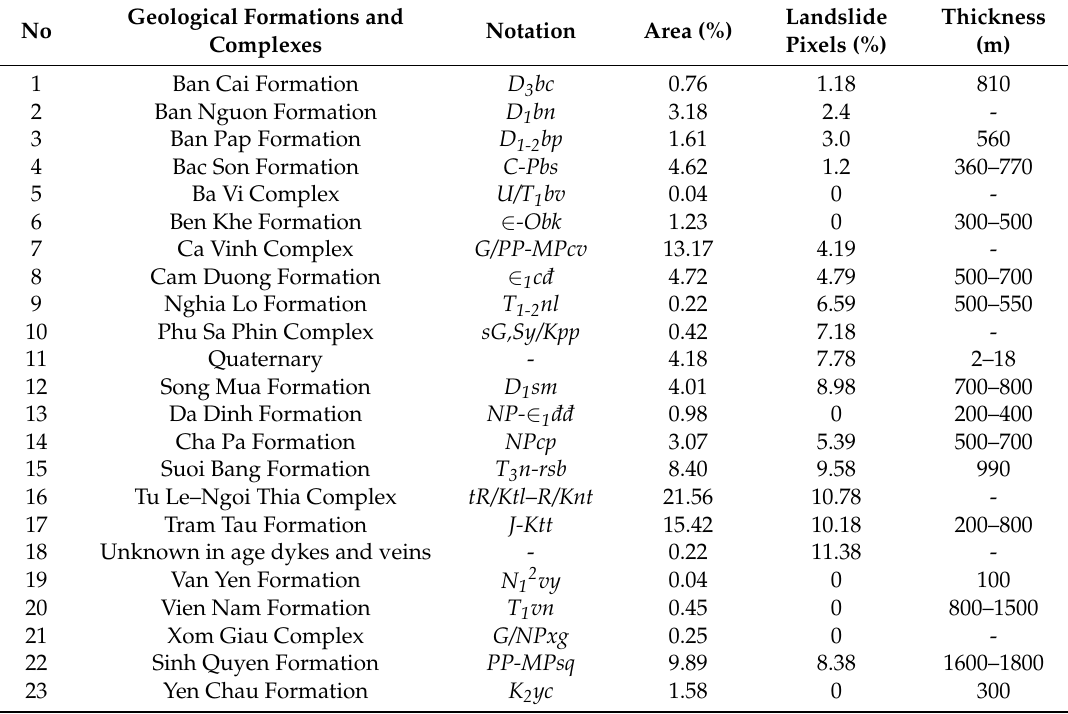
Table 1. Geological formations and complexes and the main characteristics of the research